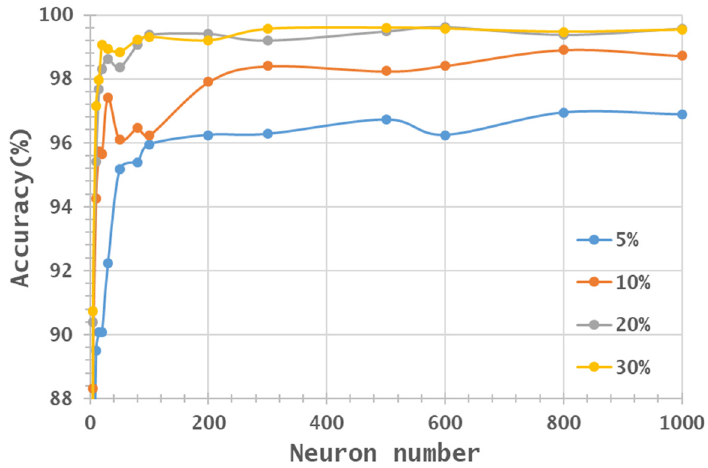
Figure 7. Accuracy distribution of IP MNF1–10 + HHT image set, varying with training sample proportion and hidden layers.